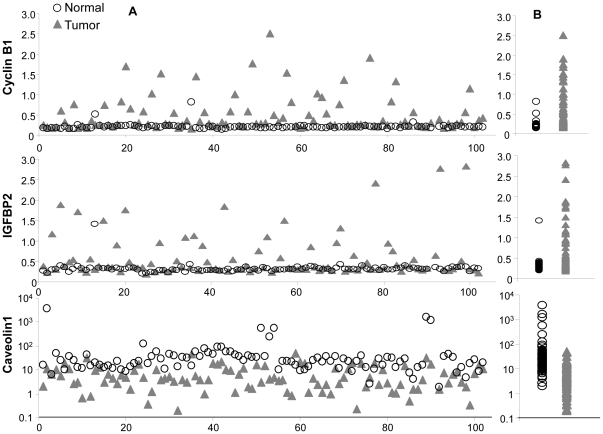
Signal intensity detected by RPPA.A) Signal intensity (Y axis) for each case (X axis) for molecules of cyclin B1, IGFBP2, and caveolin 1. B) Alighted distribution of signals in normal and tumor tissues.